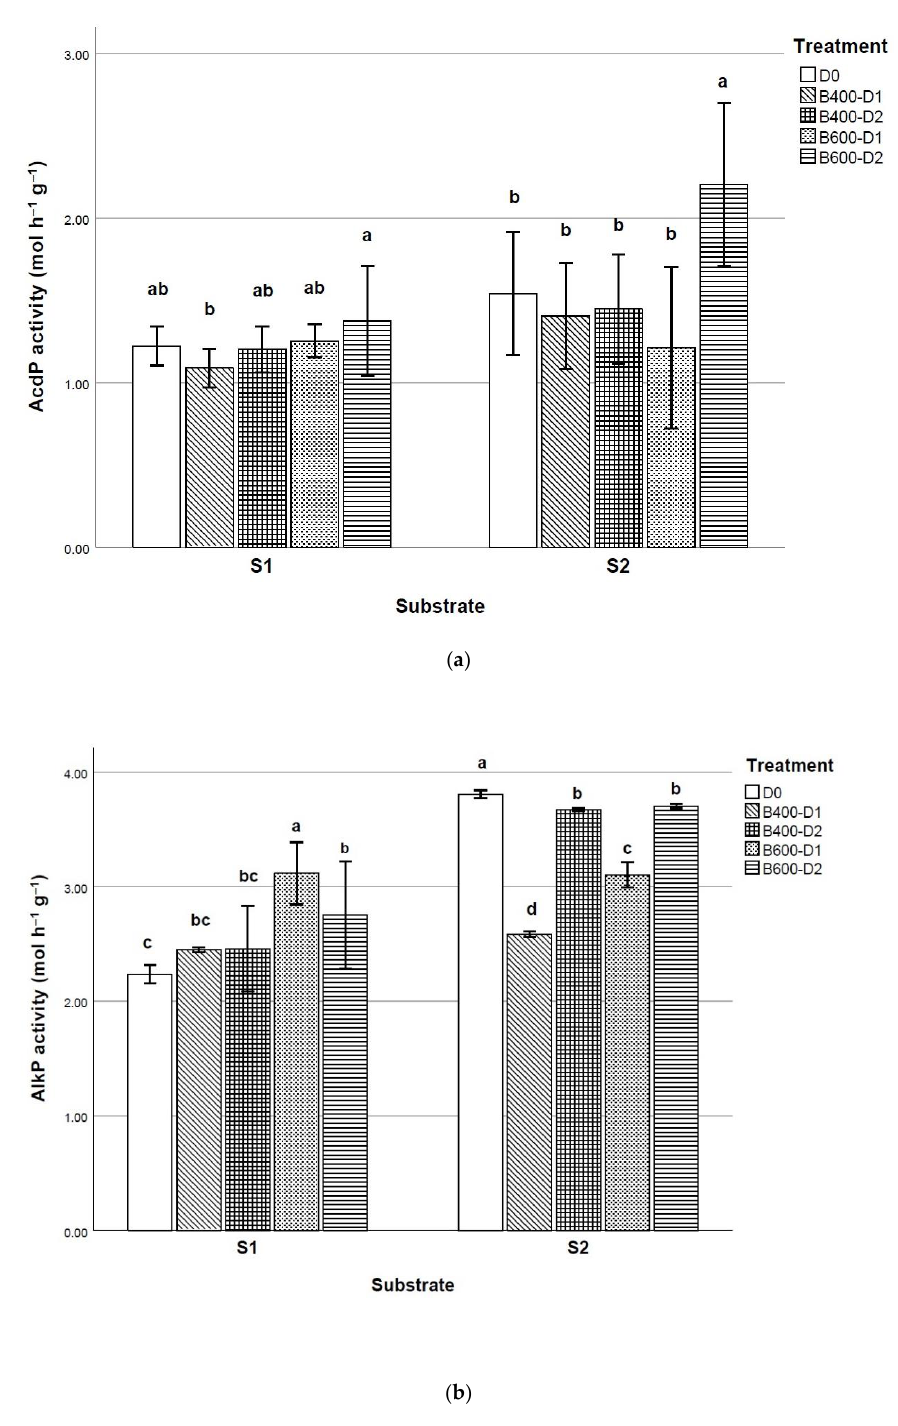
Figure 2. Effect of biochar application on ( a ) acid phosphatase activity and ( b ) alkaline phosphatase activity. (Final pyrolysis temperature of biochar B400—400 ◦ C and B600—600 ◦ C; D0–Control without biochar, D1—1.5 wt. %, D2—3 wt. %; S1—sandy-loam substrate, S2—clay-loam substrate). Different letters show statistically significant differences at p ≤ 0.05 (Tukey’s